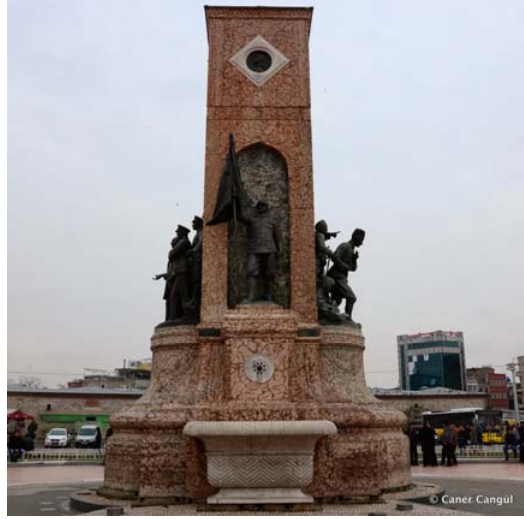
Figure 6: The republic monument in Taksim Square (Cangül,